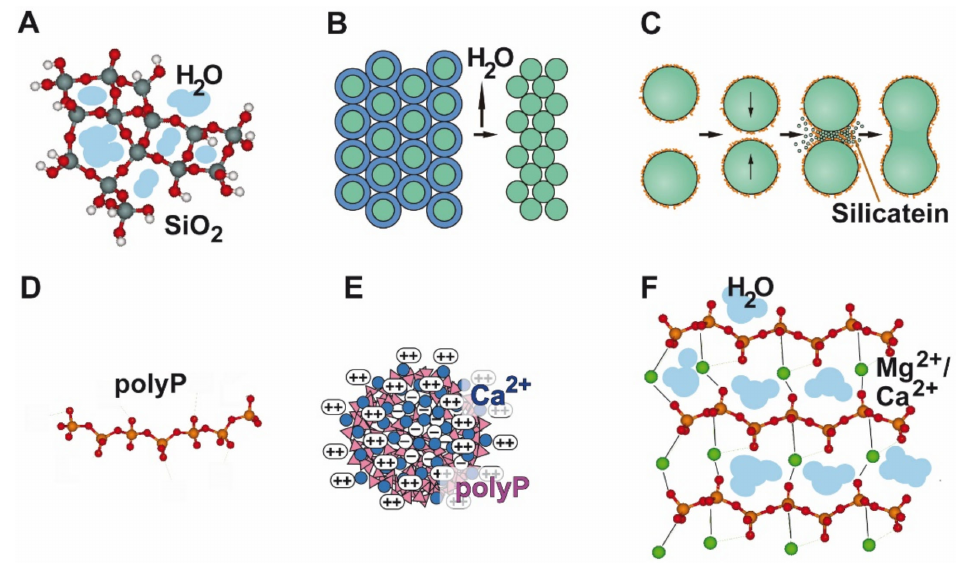
Figure 2. Different forms and phases of biosilica and bioinorganic polyP. ( A – C ) Enzymatically formed biosilica is obtained first as a water-rich gel-like product ( A ) that undergoes a hardening process by syneresis ( B ). In the presence of the silicatein, the formed amorphous spherical silica nanoparticles sinter together at ambient temperature under formation of solid biosilica blocks ( C ). ( D – F ) PolyP can be present either in a soluble form ( D ), e.g., as sodium salt (Na-polyP), or prepared in the form of nanoparticles (at alkaline pH in the presence of a stoichiometric surplus [based on phosphate] of divalent cations, e.g., Ca 2+ ( E ) or as a water-rich coacervate (at neutral pH) ( F